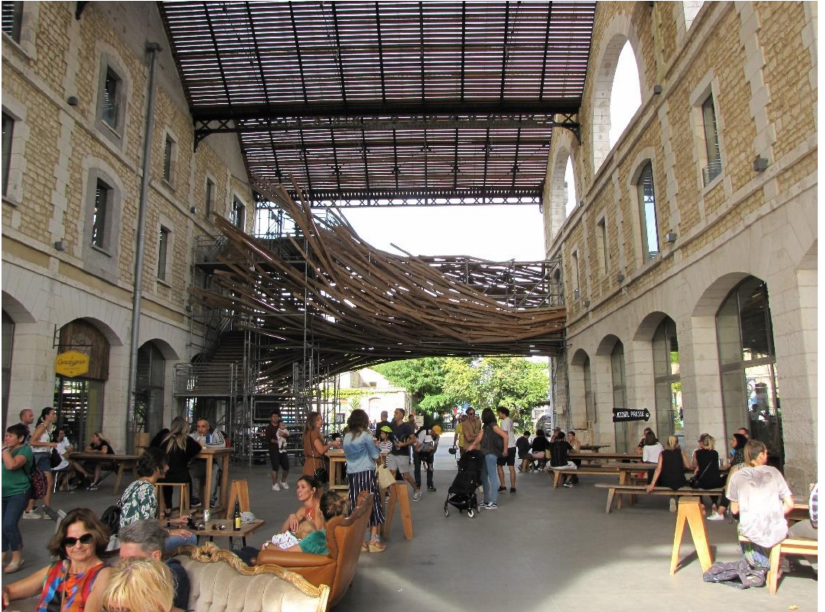
Figure 13. Niel Barracks—historic architecture that seems frozen in time and is surrounded by contemporary social activity (photo by M.